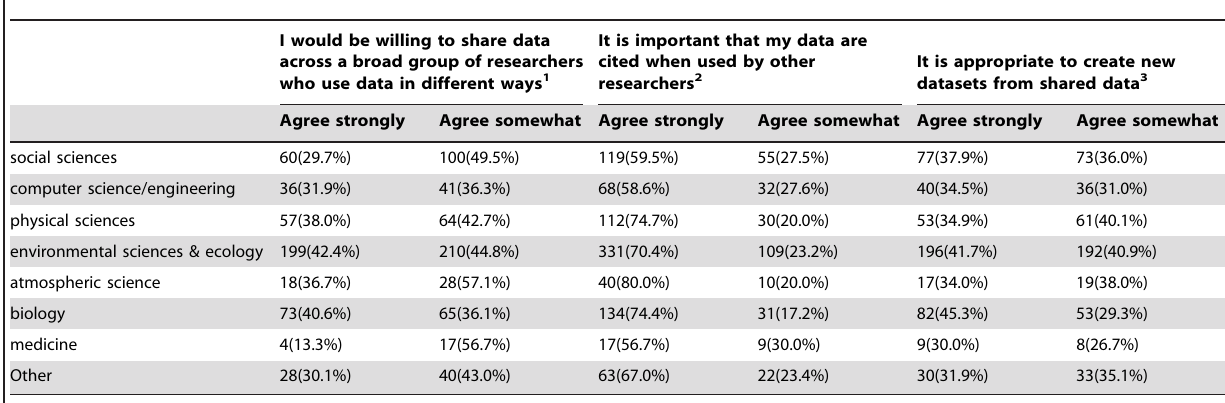
Table 20. Conditions for data sharing for reuse by subject